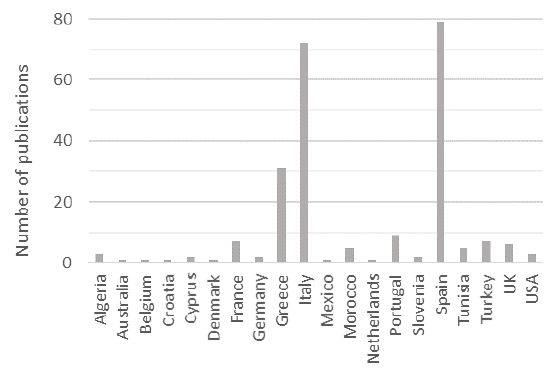
Figure 3. Publications per country on table olives that address lactic acid bacteria.